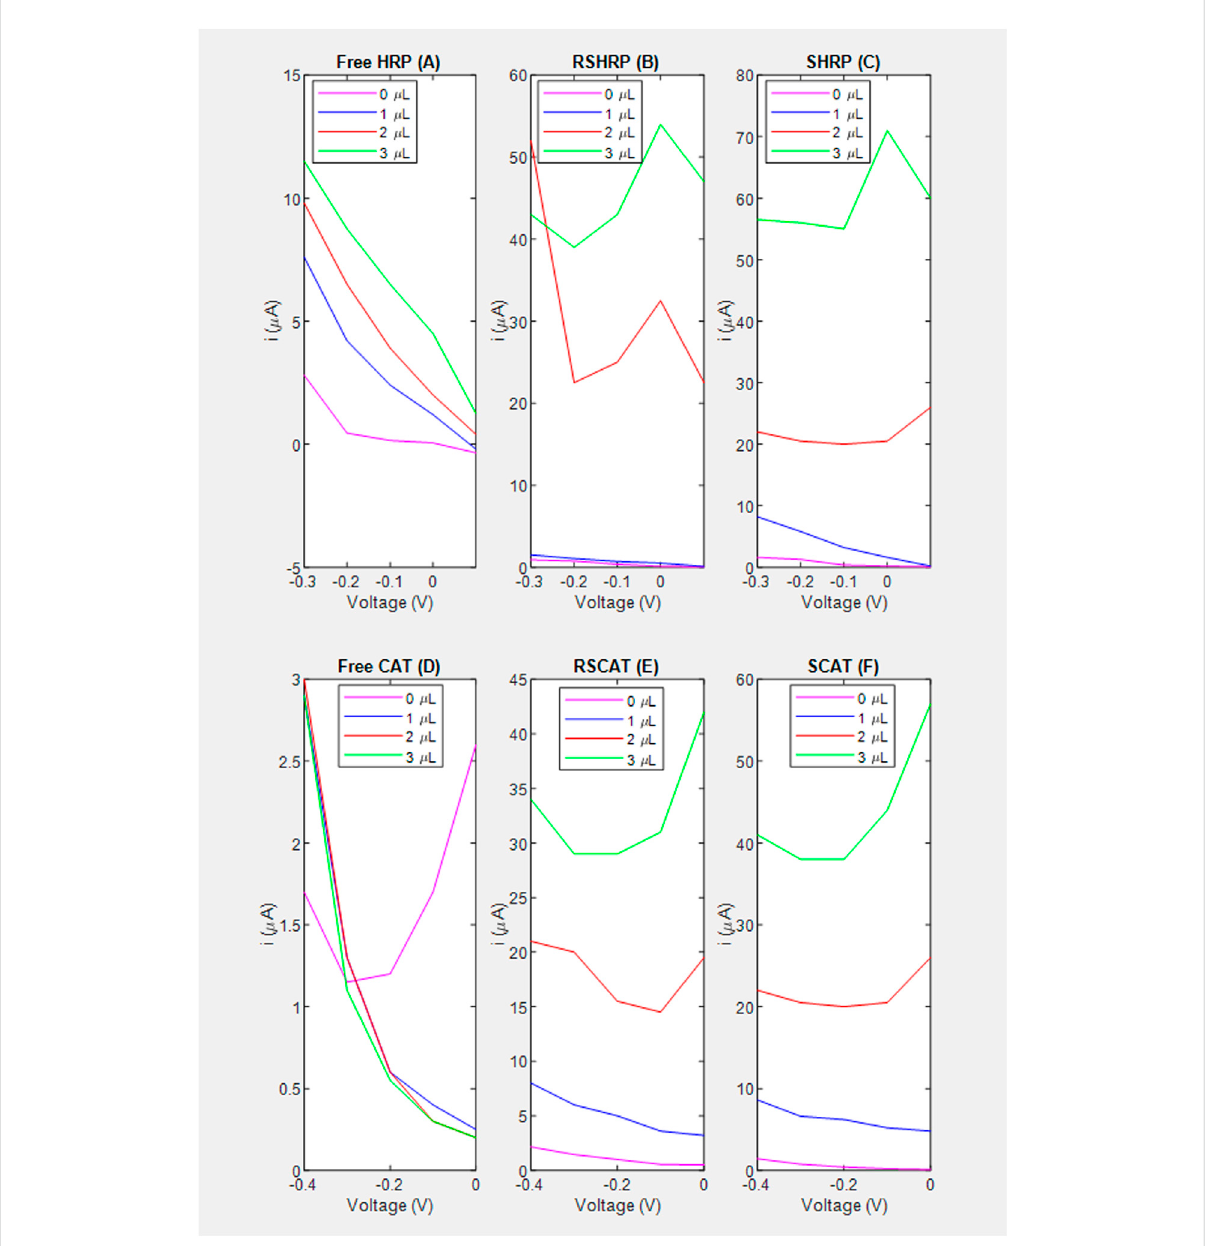
FIGURE 4 Voltage vs. current based on amperometric data for the estimation of the signal to noise ratio. (A) Free enzyme; (B) RSHRP nanocomposite fi lm where chitosan is not in contact with the SPCE; (C) SHRP nanocomposite fi lm where chitosan is in contact with the SPCE; (D) Free enzyme denoted as FreeCAT; (E) RSCAT nanocomposite fi lm where chitosan is not in contact with the SPCE; (F) SCAT nanocomposite fi lm where chitosan is in contact with the